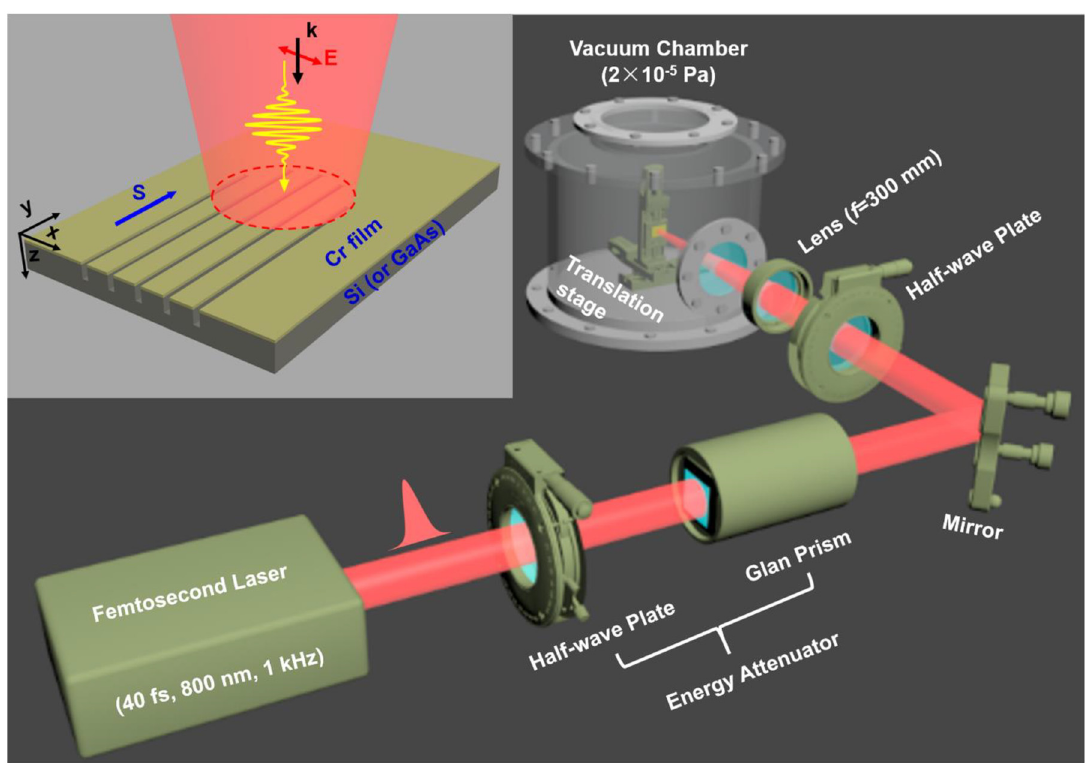
Figure 1: A schematic diagram for super-regular femtosecond laser nanolithography on the Cr/Si material based on dual-interface plasmonic coupling.Here,thesampleisplacedwithinavacuumchamberwithanairpressureof P =2.0 × 10 − 5 Pa.Theinsetshowsthesuperiorformation of nanograting arrays via a line-scanning process. Here, k represents the wave vector of the incident laser; E for the electric- fi eld vector or the polarization direction of the incident light, S for the direction of the sample